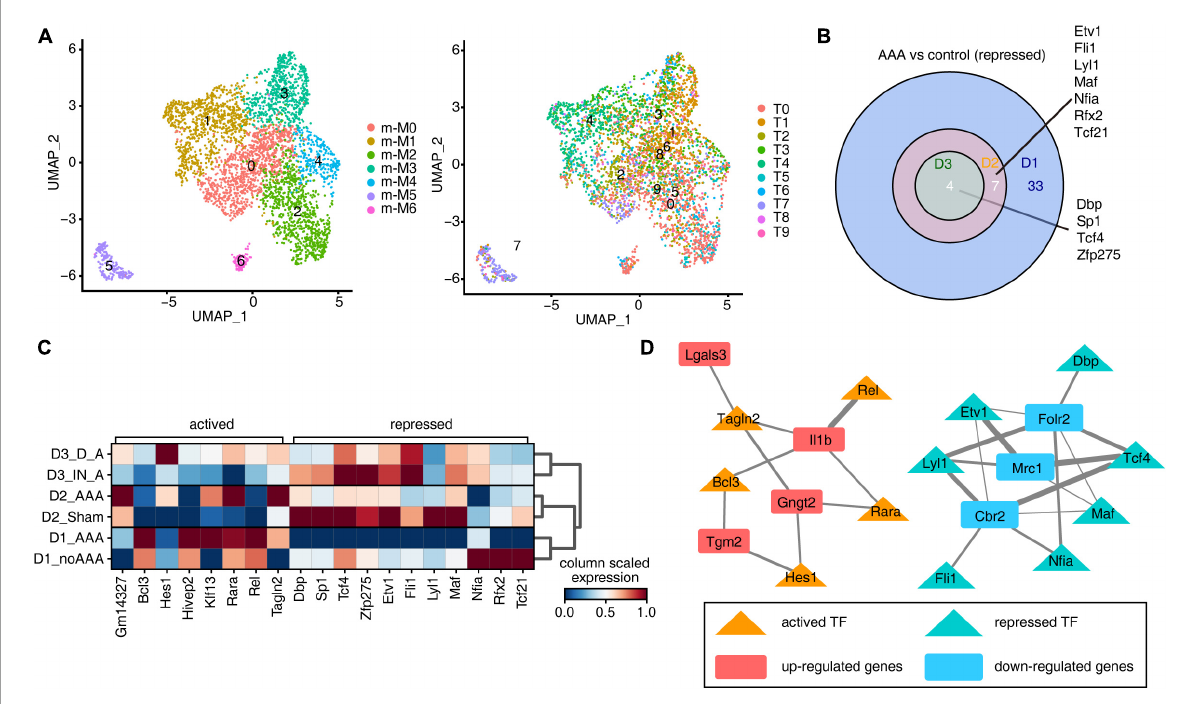
FIGURE3 Different abdominal aortic aneurysm (AAA) models had similar inhibition characteristics of transcription factors. (A) Uniform manifold approximation and projection (UMAP) displayed the distributions of 10 cell types based on regulons (right panel). Colors indicated cell types. (B) Venn diagram showing the co-repressed regulons comparing AAA macrophages/monocytes (M ϕ /Mo) with control group from three datasets. (C) Unsupervised clustering heatmap displayed the active states of co-actived and co-repressed regulons in each sample groups. Red colors indicated that the network was more activated, blue colors indicated that the network was more silenced. (D) Cytoscape showed the regulatory networks comprising transcription factors from panel (C) and their target co-differentially expressed genes (DEGs) underlying M ϕ /Mo. Edges connected transcription factor-target gene pairs while nodes represented